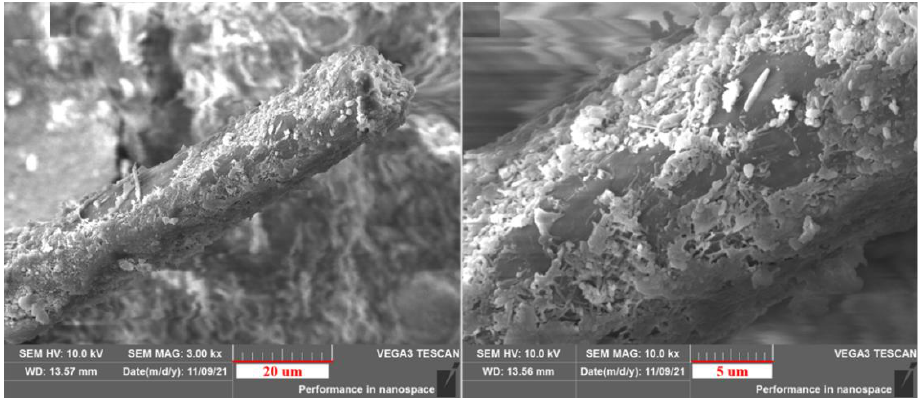
Figure 11. The micromorphology of cow hair fiber inside the material.